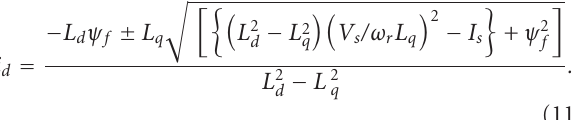
Figure 1: Voltage-limited ellipses of IPMSM for flux-weakening method of speed